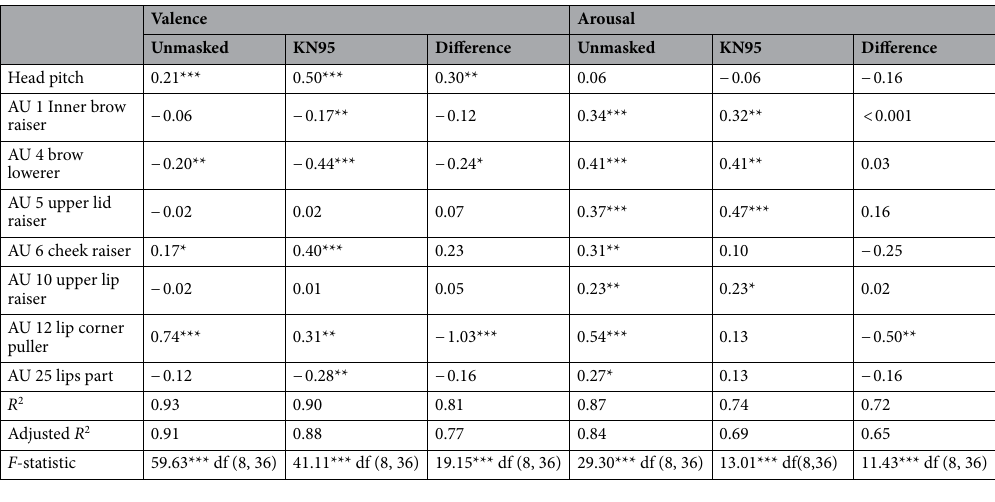
Table 2. Multiple linear regression results. The independent variables (rows) are FACS AUs that have been previously found to be associated with either positive or negative valence. Six different models were run, each predicting one of the dependent variables (columns): the mean scores in valence and arousal for the unmasked and the KN95 conditions, as well as for the difference between the two conditions. *** p < 0.001, ** p < 0.01, * p <